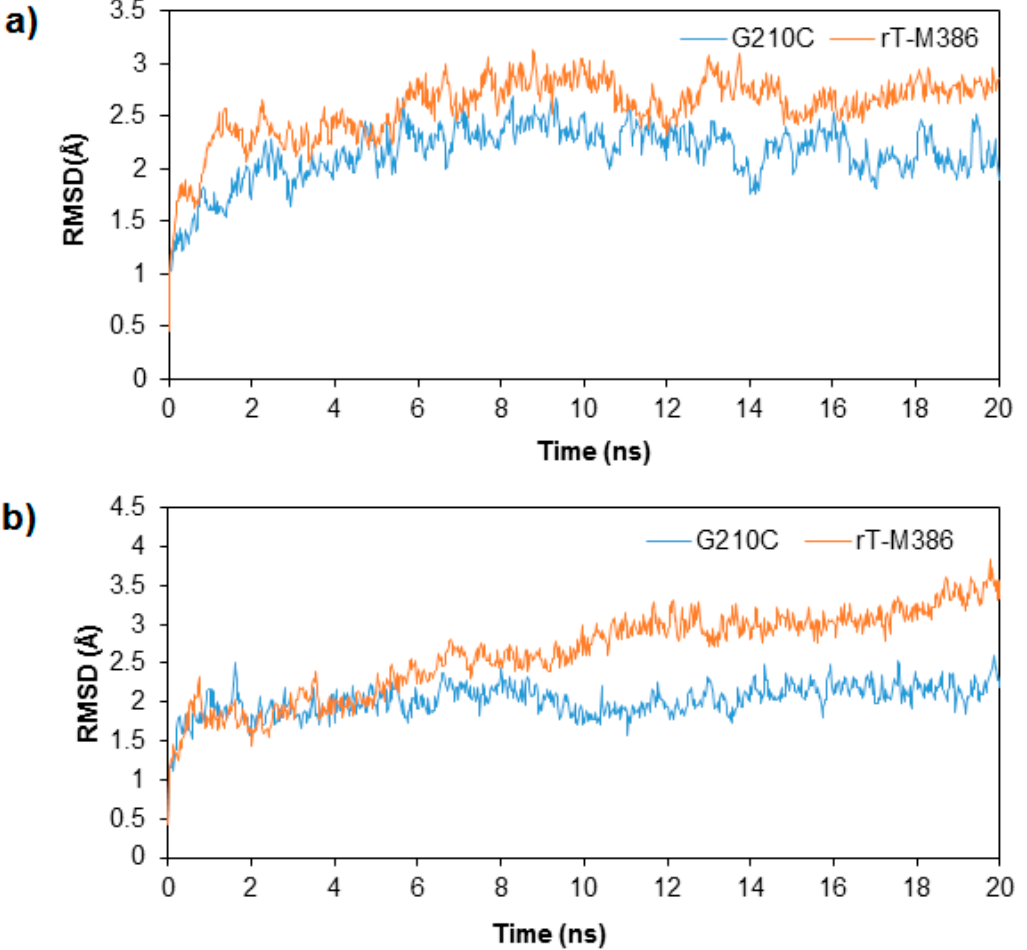
Figure 4. Root Mean Square Deviation (RMSD) profile for rT-M386 and G210C as per time. ( a ) at 25 °C ( b ) at 50 °C. The simulation was analyzed over 20 ns trajectories. The RMSD of rT-M386 and G210C lipases are indicated by red line and blue line, respectively.